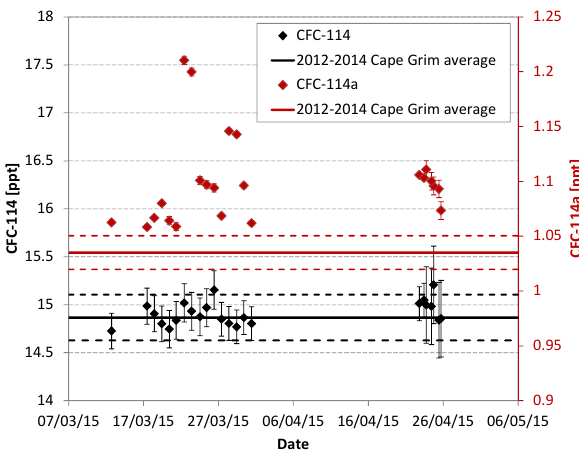
Figure 6. Mixing ratios of CFC-114 and CFC-114a from samples collected during a ground-based campaign near Hengchun, Taiwan, in early 2015 (diamonds) compared to mixing ratios observed at Cape Grim averaged from 2012 to 2014 (lines). Uncertainties (error bars and dashed lines) are 1 σ standard